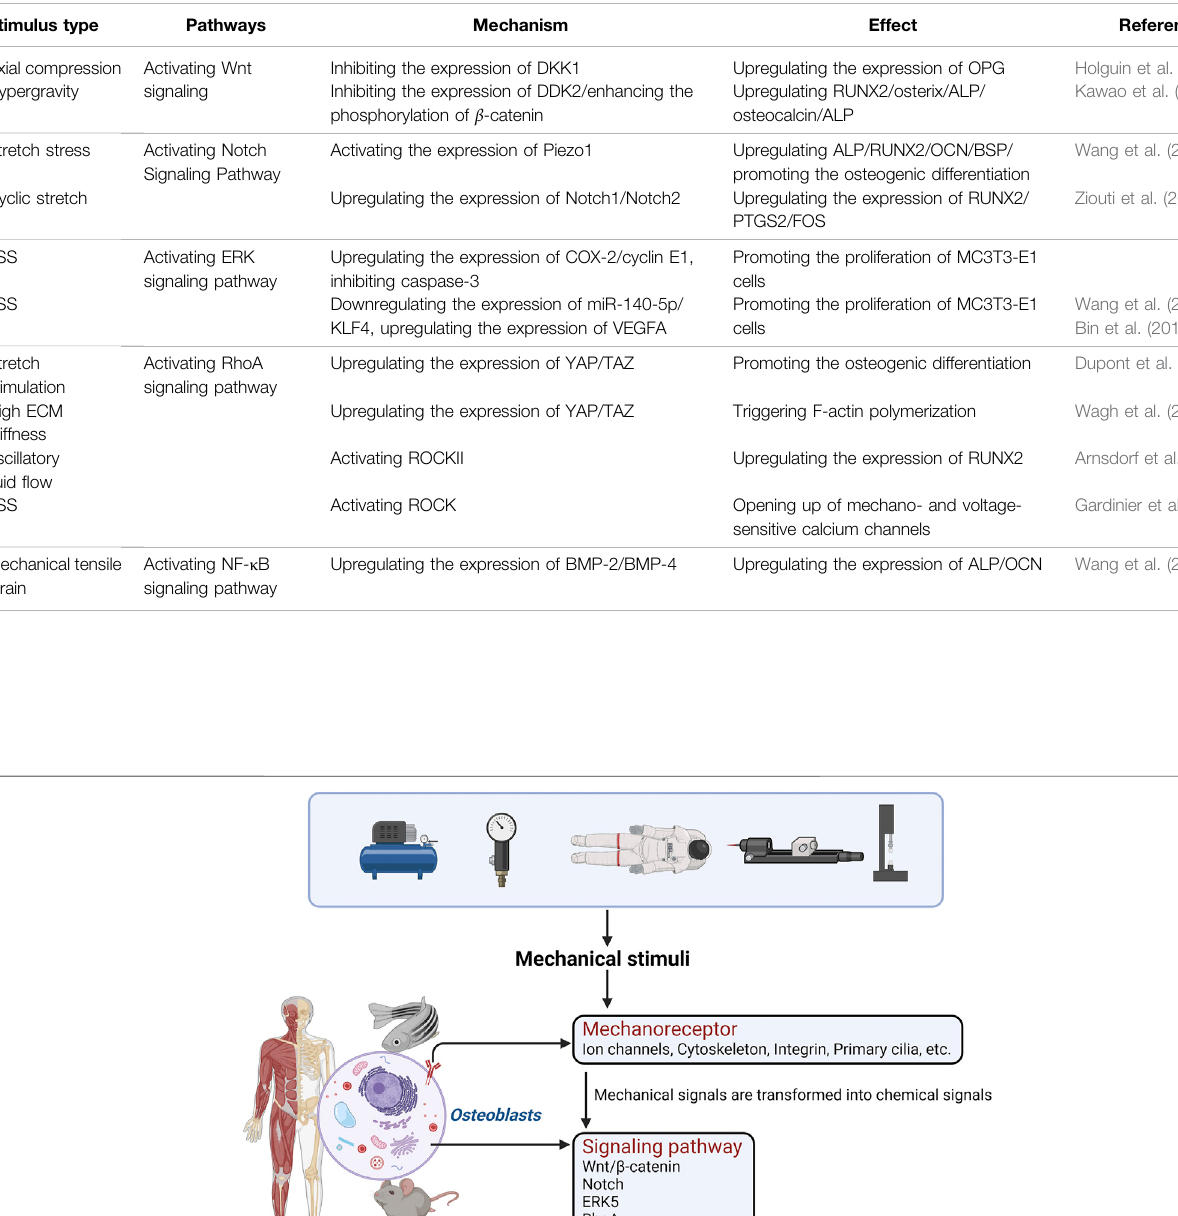
TABLE 1 | Signal Pathways Mediating Effects of Mechanical Stress Stimulation on Osteoblast like cells. FSS, fl uid shear stress; OPG: osteoprotegerin; DKK, Dickkopf- related protein; RUNX2,Runt-related transcription factor 2;ERK, Extracellular-regulated proteinkinase; BMP, BoneMorphogeneticProtein;ALP, alkaline phosphatase;